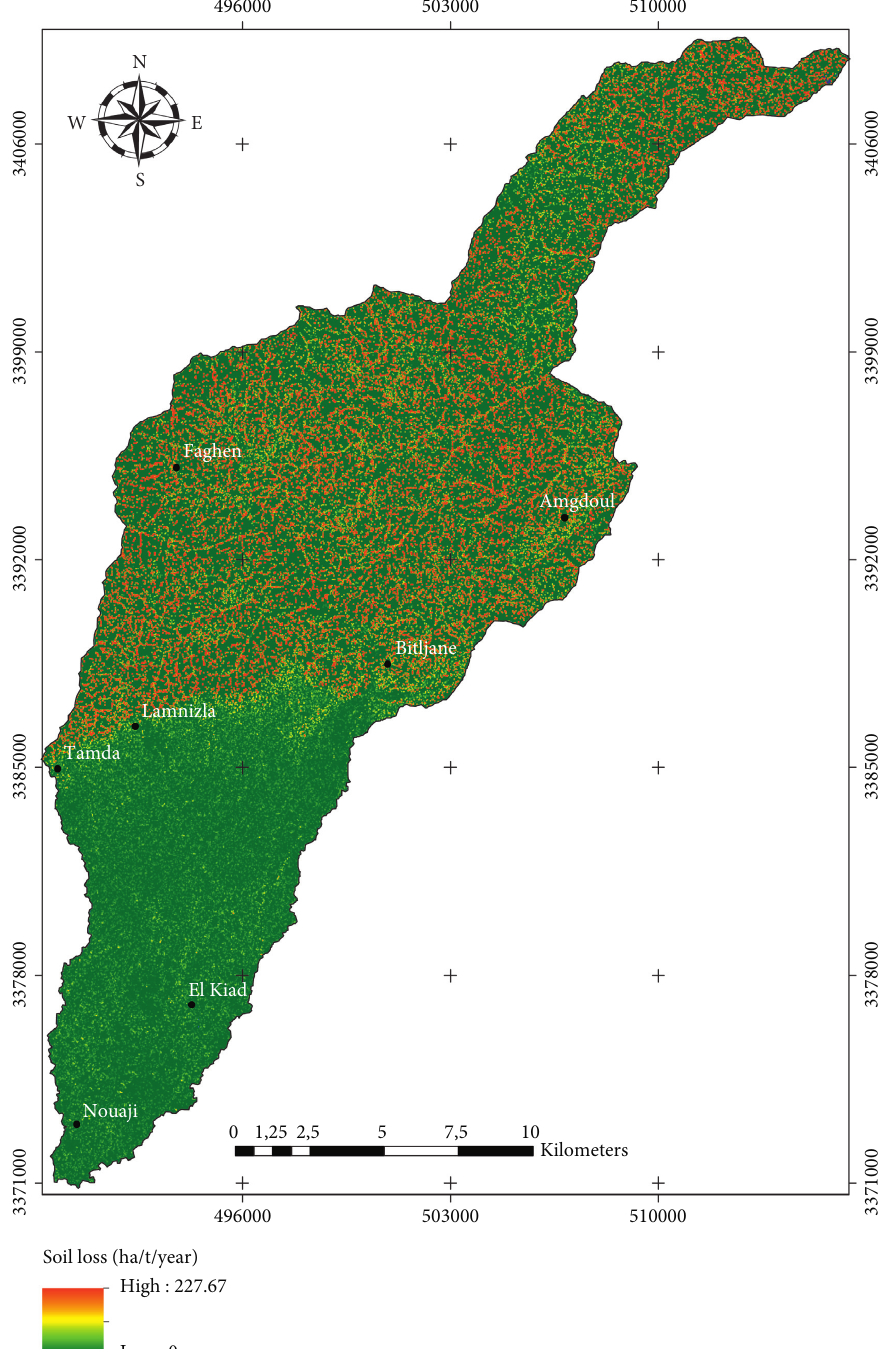
Figure 9: Spatial distribution of potential erosion risk map of Beni Mohand River